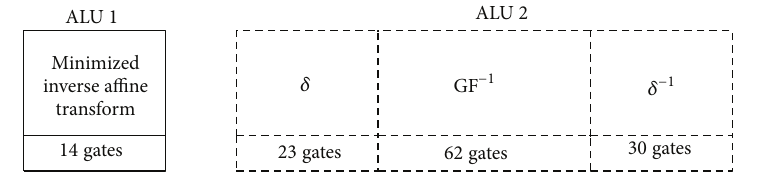
Figure 15: Illustration of the independent ALU set for the minimized inverse affine transform.